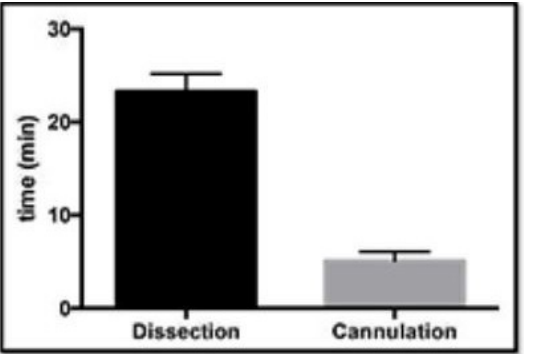
Figure 5. The time taken for dissection of the aortic roots and cannulation in the valve suspension chamber.